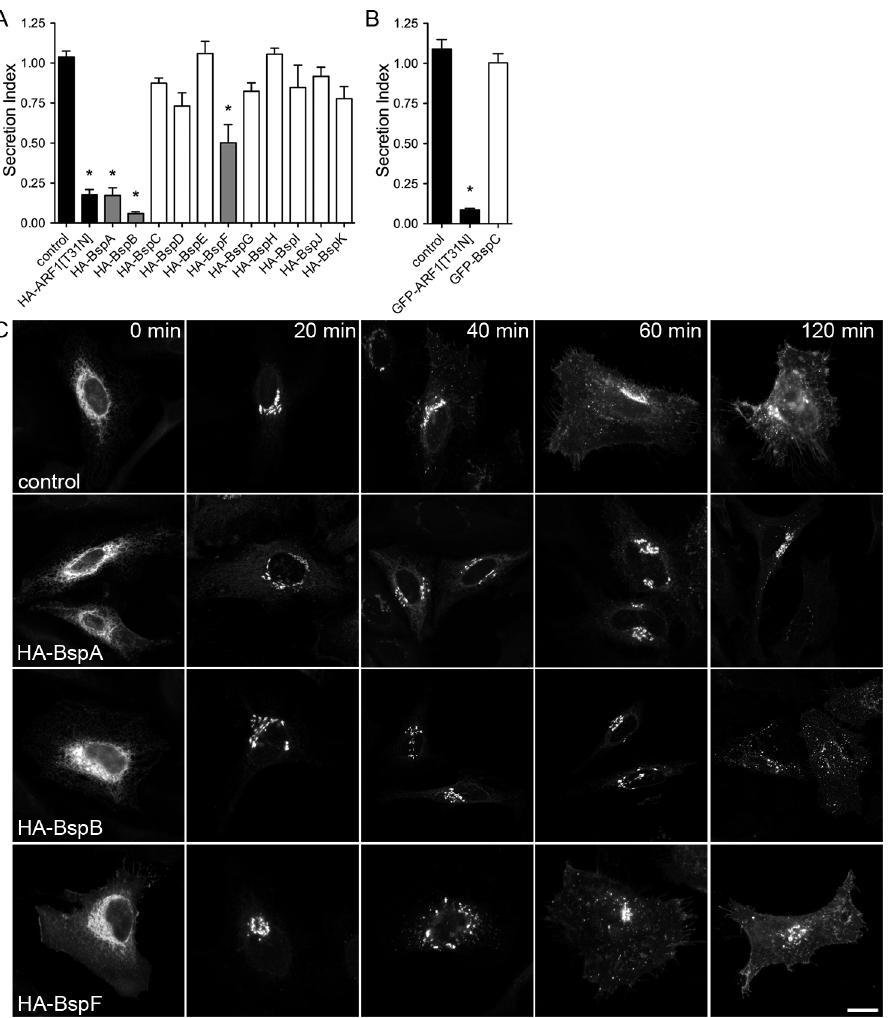
Figure 5. Ectopic expression of BspA, BspB and BspF in HeLa cells interferes with the host secretory pathway. (A and B) Quantitation of SEAP secretion in HEK 293T cells expressing Bsp proteins. HEK 293T cells were co-transfected with plasmid pSEAP-2 and plasmids encoding either HA- (A) or GFP- (B) tagged Bsp proteins are indicated. Twenty-four hours after transfection, SEAP was measured and expressed as a secretion index. Empty vectors served as control and expression of GDP-locked ARF1[T31N] served as a positive control. Data points represent the mean 6 SEM of three independent experiments performed in triplicate ( * indicates a P value , 0.001). (C) Representative confocal micrographs of HeLa cells showing VSV- Gts045-GFP temporal trafficking in HeLa cells expressing the HA-tagged indicated Bsp proteins. HeLa cells were co-transfected with plasmids expressing VSV-Gts045-GFP and the indicated Bsp protein, incubated for 20 h at 40 u C. Cells were then treated with cycloheximide and shifted to 32 u C at t=0 min to allow VSV-Gts045-GFP transport to occur. Cells were fixed and immunostained for GFP at the indicated times post-temperature shift. Scale bar, 10 m m.